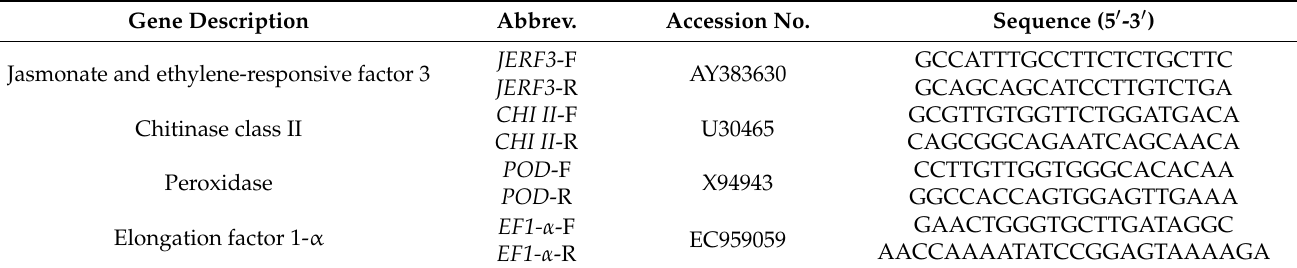
Table 2. Primer sequences of the investigated